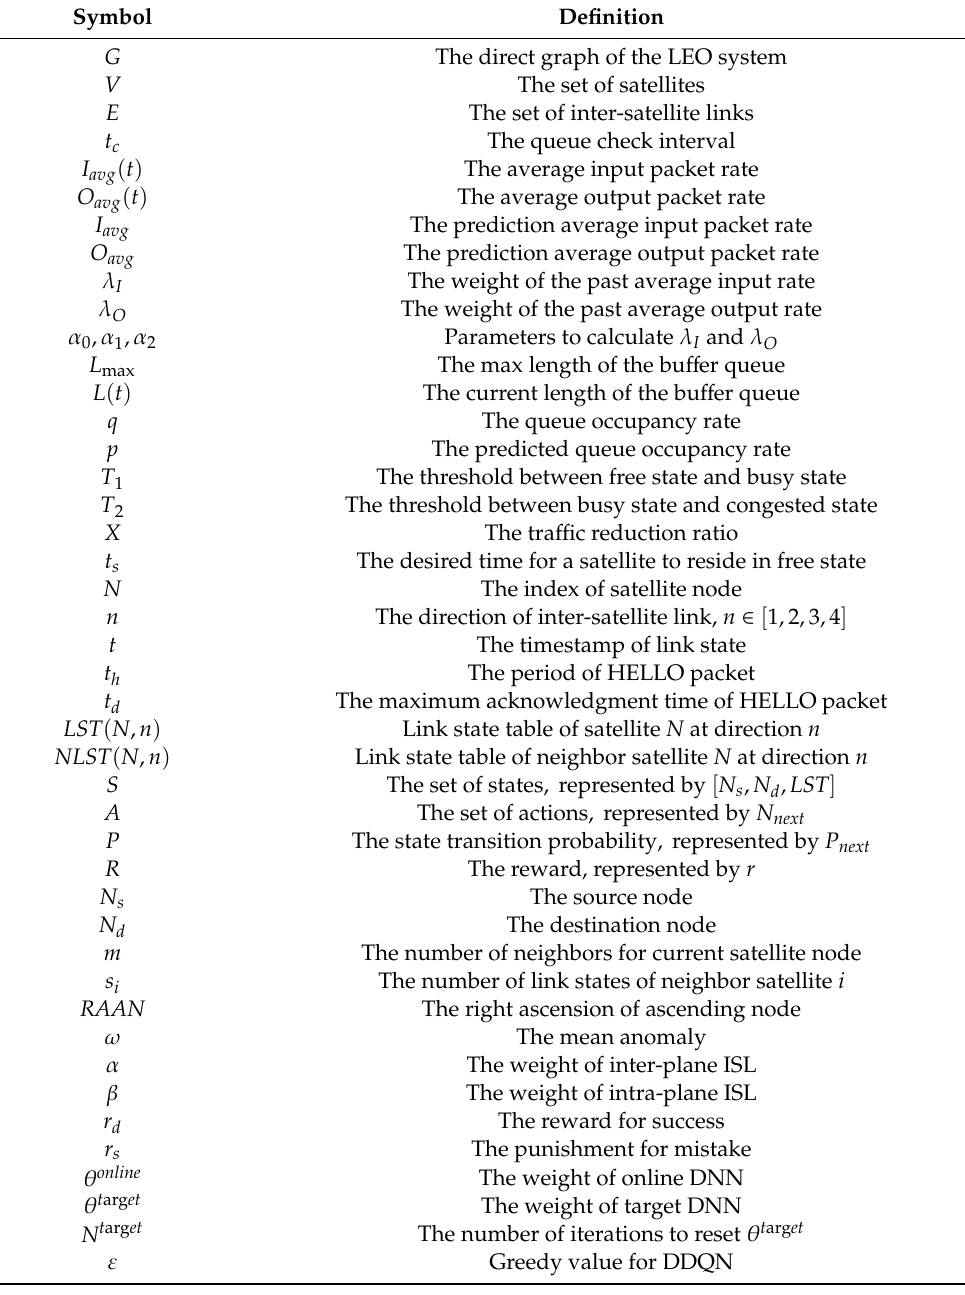
Table 1. Definition of the